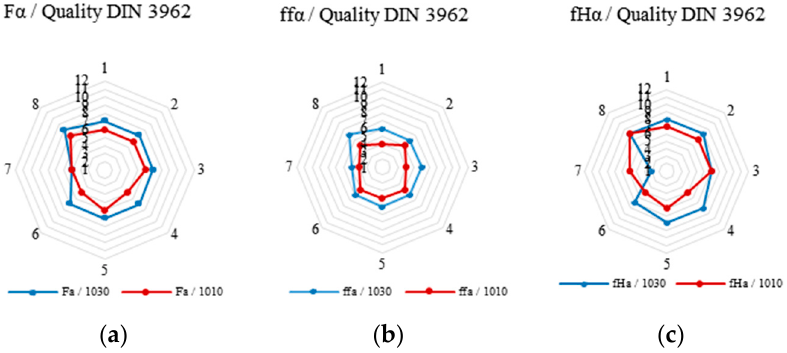
Figure 10. Comparison of gear quality in profile direction: ( a ) overall profile deviation, for 1030 and 1010 inserts; ( b ) profile form deviation, for 1030 and 1010 inserts; ( c ) profile angle deviations for 1030 and 1010 inserts.